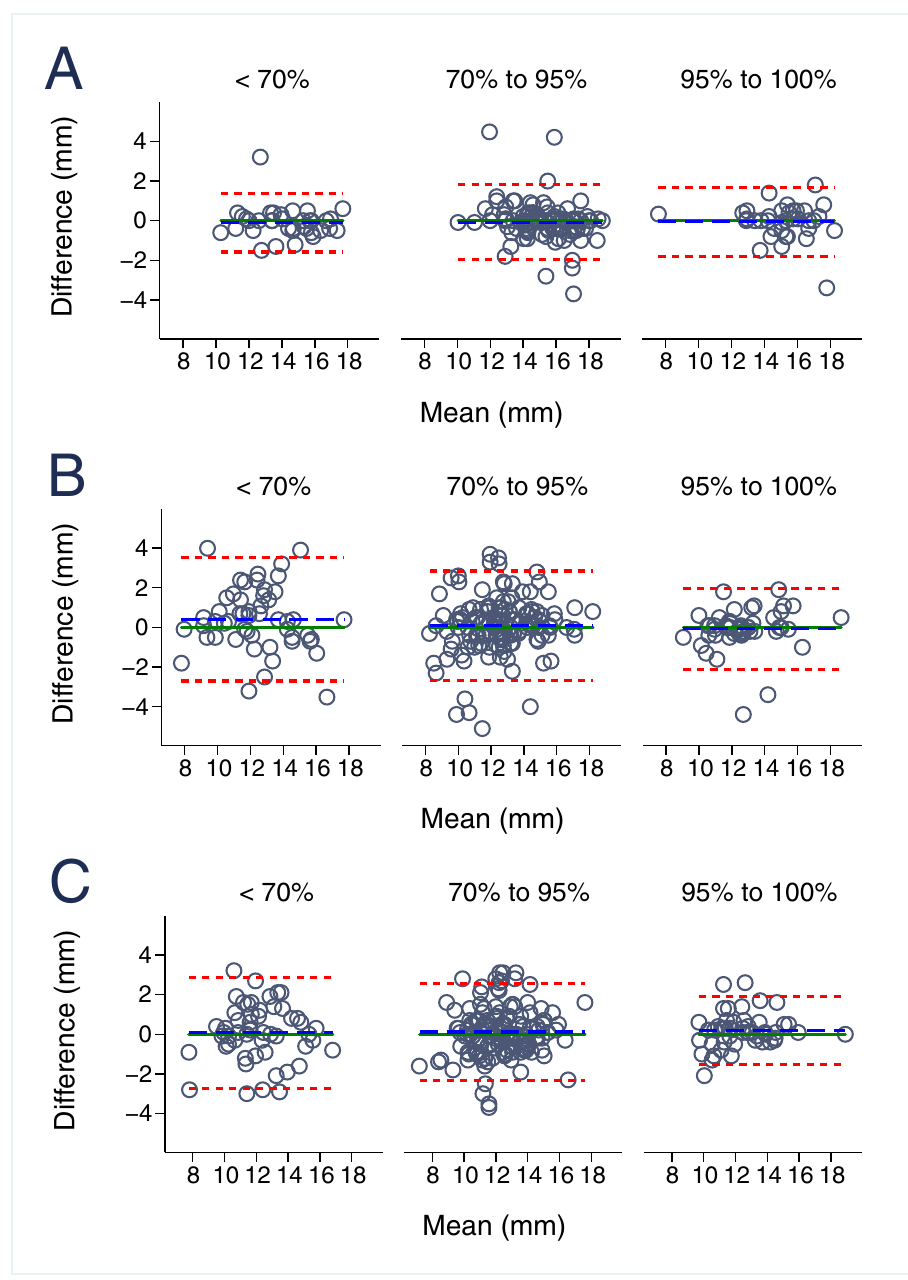
Fig 4. Interobserver reproducibility of MAPSE imaging in relation to echocardiographic image quality. A. Interobserver variability for m-mode derived MAPSE, B. Interobserver variability for B-Mode lateral derived MAPSE, C. Interobserver variability for B-Mode septal derived